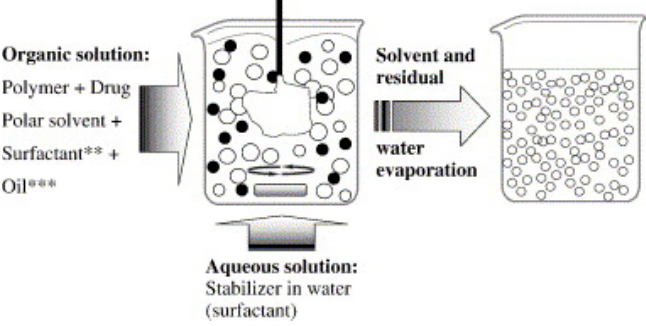
Figure 4. Schematic representation of the nanoprecipitation (solvent displacement) technique. Reprinted with permission from Reference [53]. Copyright 2006 Elsevier.